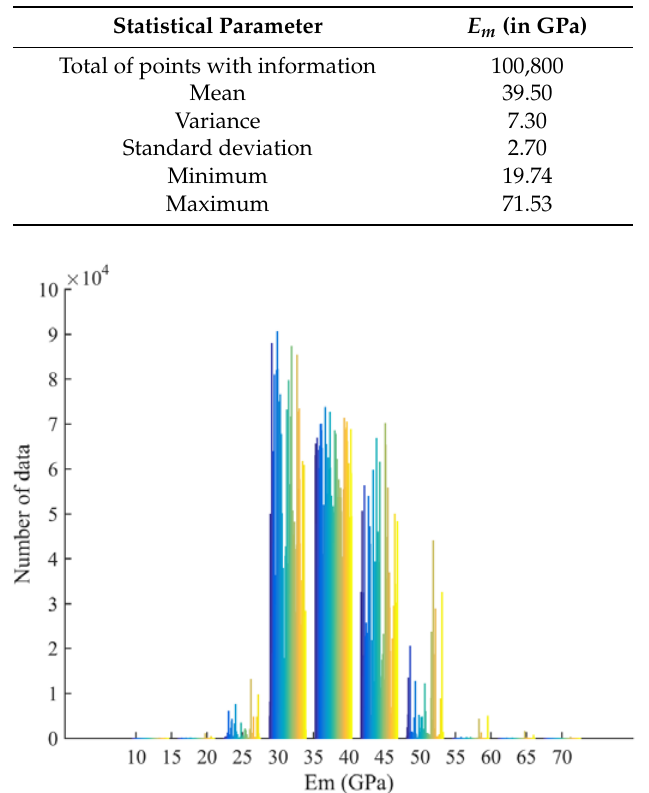
Table 4. Statistical analysis of the E m (in GPa) values obtained through the application of empirical formulae using the geotechnical information.